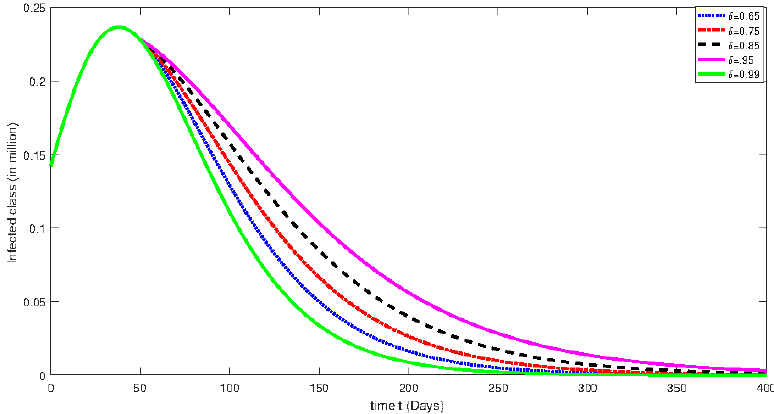
Figure 10. Numerical solution for infected class for the given days and using different fractional orders with isolation rate of